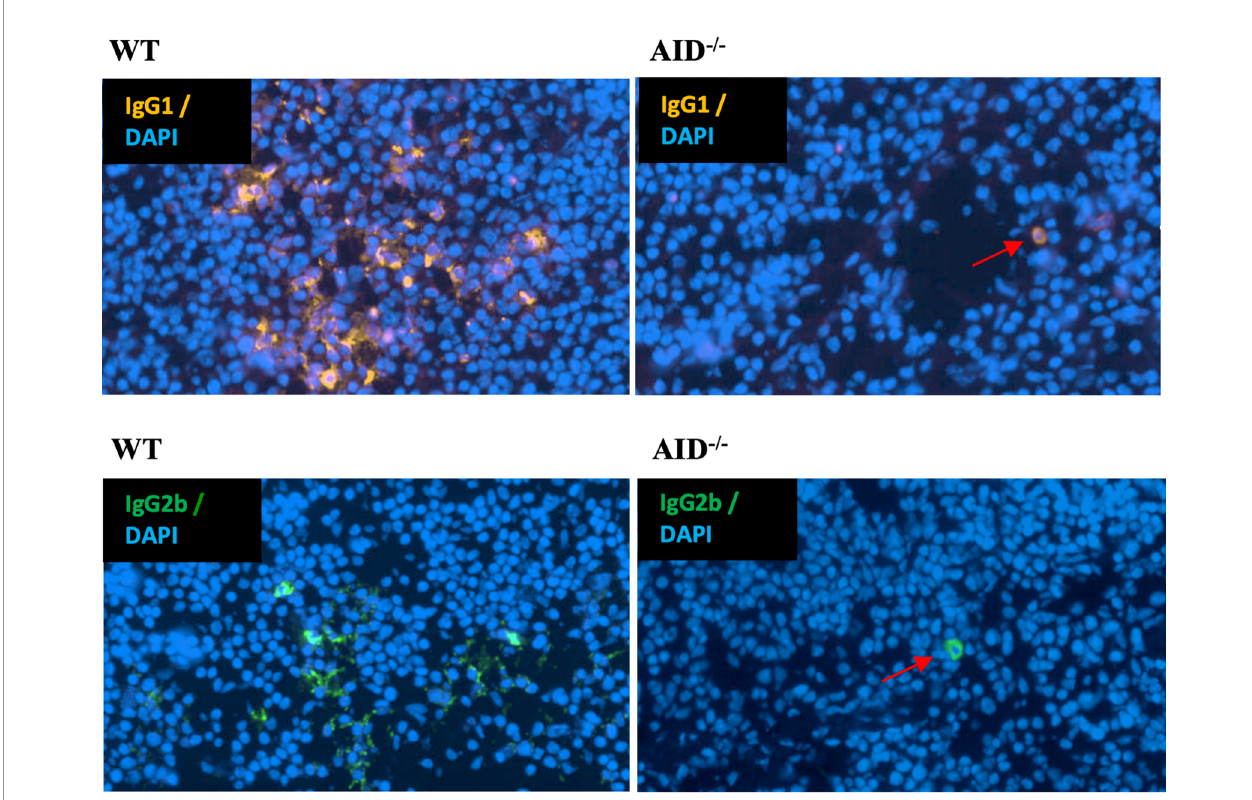
FIGURE 5 | Identi fi cation of rare cells producing class-switched Ig in spleens from immunized animals. Representative microscopy fi elds from slides of spleen tissues obtained from either WT (left) or AID-de fi cient (right) immunized mice, stained either for mouse IgG1 (top) or IgG2b (bottom). Red arrows indicate rare switched plasma cells in spleen tissue from an AID-de fi cient